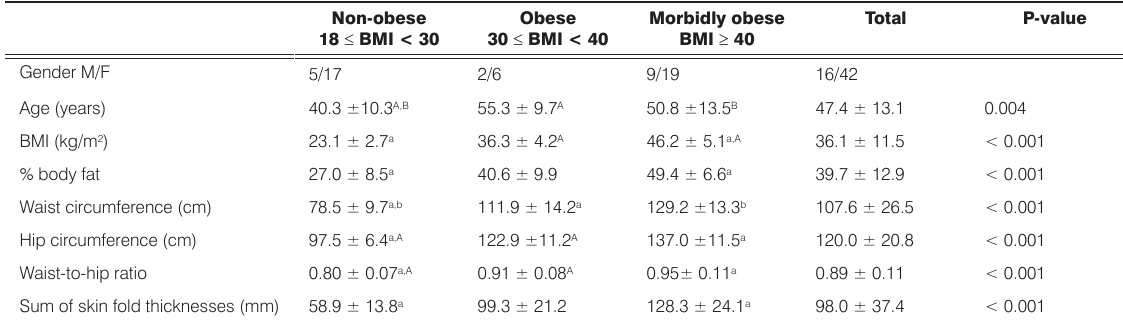
Table 2. Clinical and anthropometric data from the studied population in the study